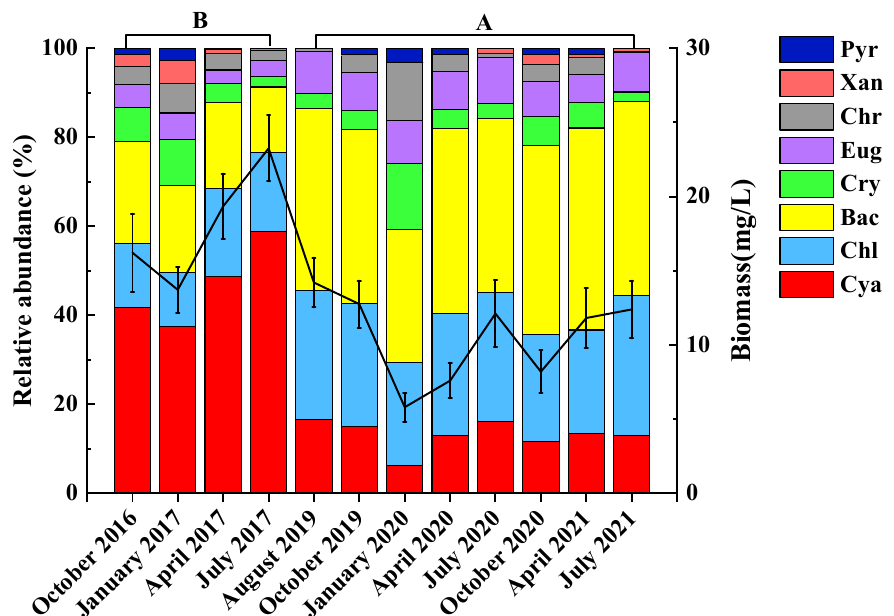
Figure 6. Temporal variation of the phytoplankton biomass before and after the aquatic vegetation restoration. The left axis or bar indicated the relative abundance of phytoplankton biomass, and the right axis or dark line indicates the mean biomass (average and standard deviation) of all points in Caizi Lakes on each sampling date. Abbreviations are used in the graph: Pyr: Pyrrophyta, Xan: Xanthophyta, Chr: Chrysophyta, Eug: Euglenophyta, Cry: Cryptophyta, Bac: Bac: Bacillariophyta, Chl: Chlorophyta, Cya: Cyanobacteria. Capital letters B and A indicated before and after aquatic plant restoration, respectively.